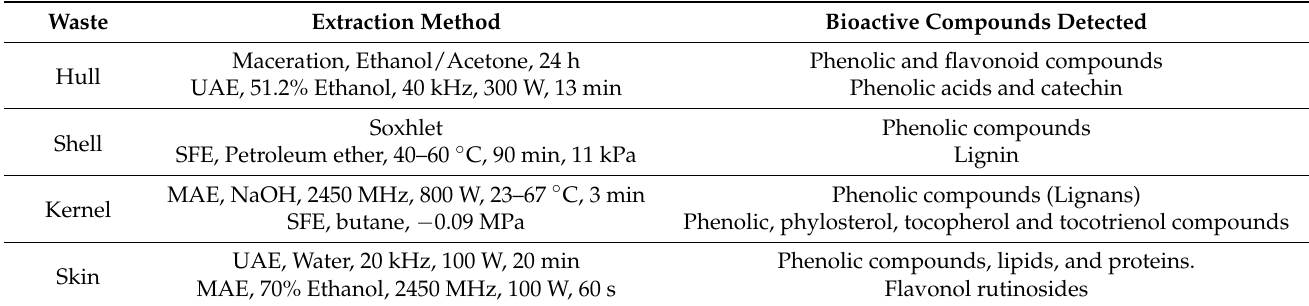
Table 6. Summary of different extraction procedures applied to almond by-products (almond hull, almond kernel, almond shell, and almond skin) for recovery of bioactive compounds (adapted from